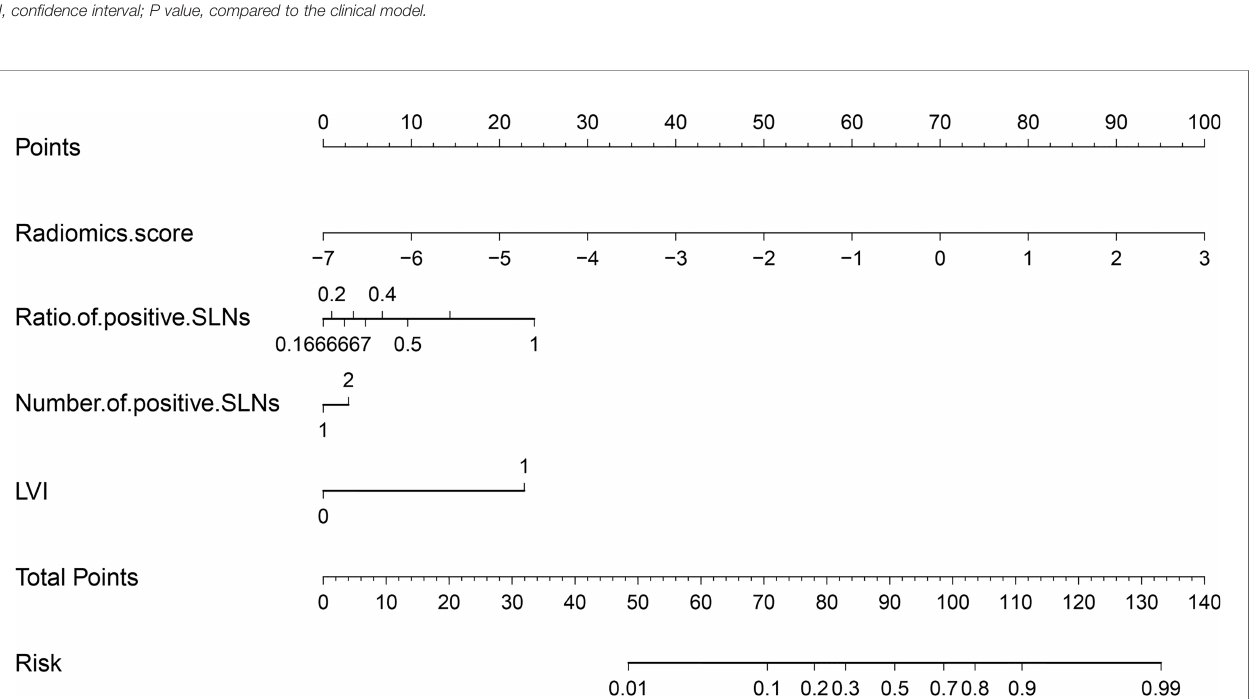
CI, con fi dence interval; P value, compared to the clinical model.